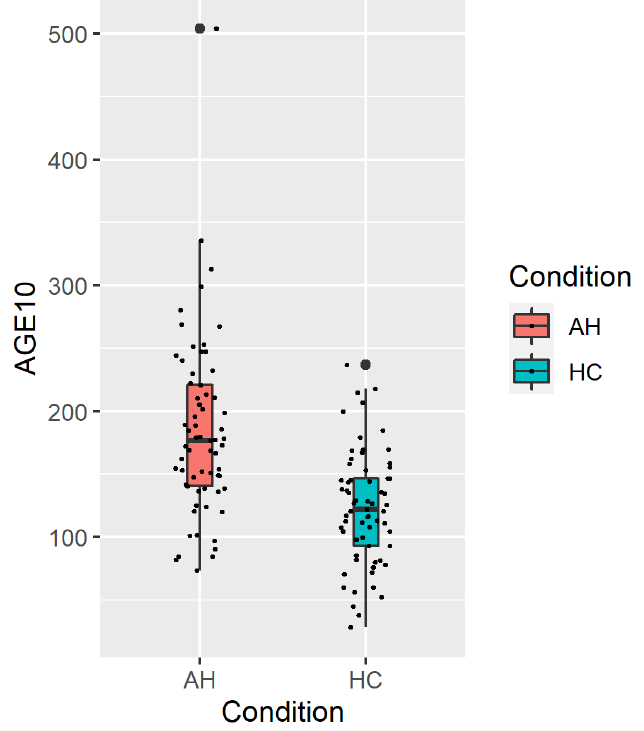
Figure 1. AGE10 concentration (µg/mL) in groups. AH: alcoholic hepatitis; HC: healthy control.